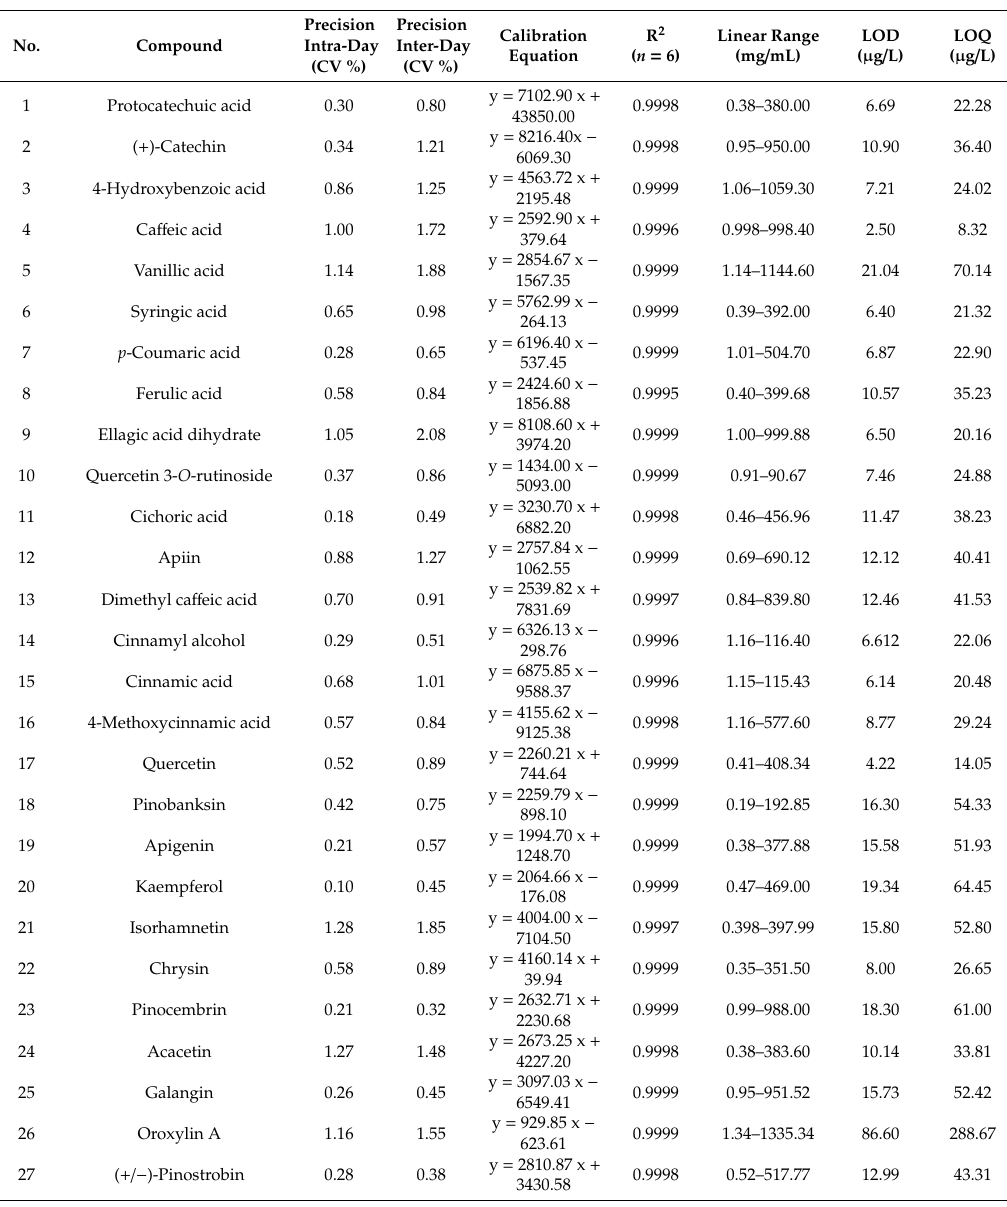
Table 1. HPLC-DAD (High Performance Liquid Chromatography–Diode Array Detector) validation parameters ( n =